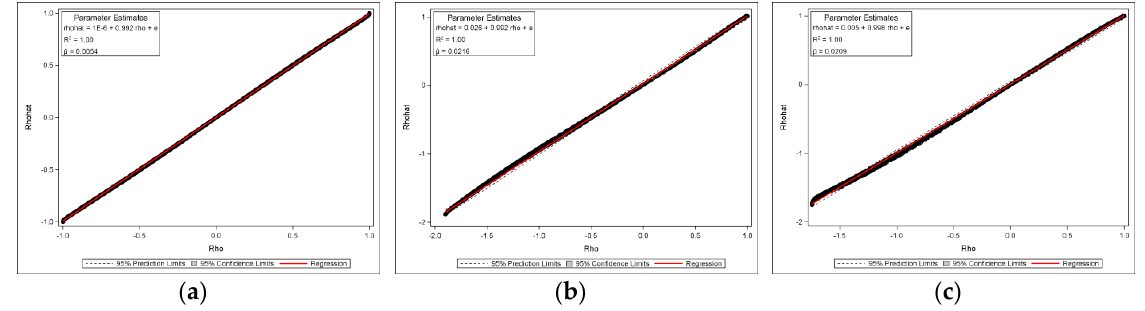
Figure A1. Bivariate regression results of ˆ ρ MC as a function of ˆ ρ for three 70-by-70 ( n = 4900 ) regular tessellations: ( a ) square rook adjacency case; ( b ) square queen adjacency case; and, ( c ) hexagonal case data.